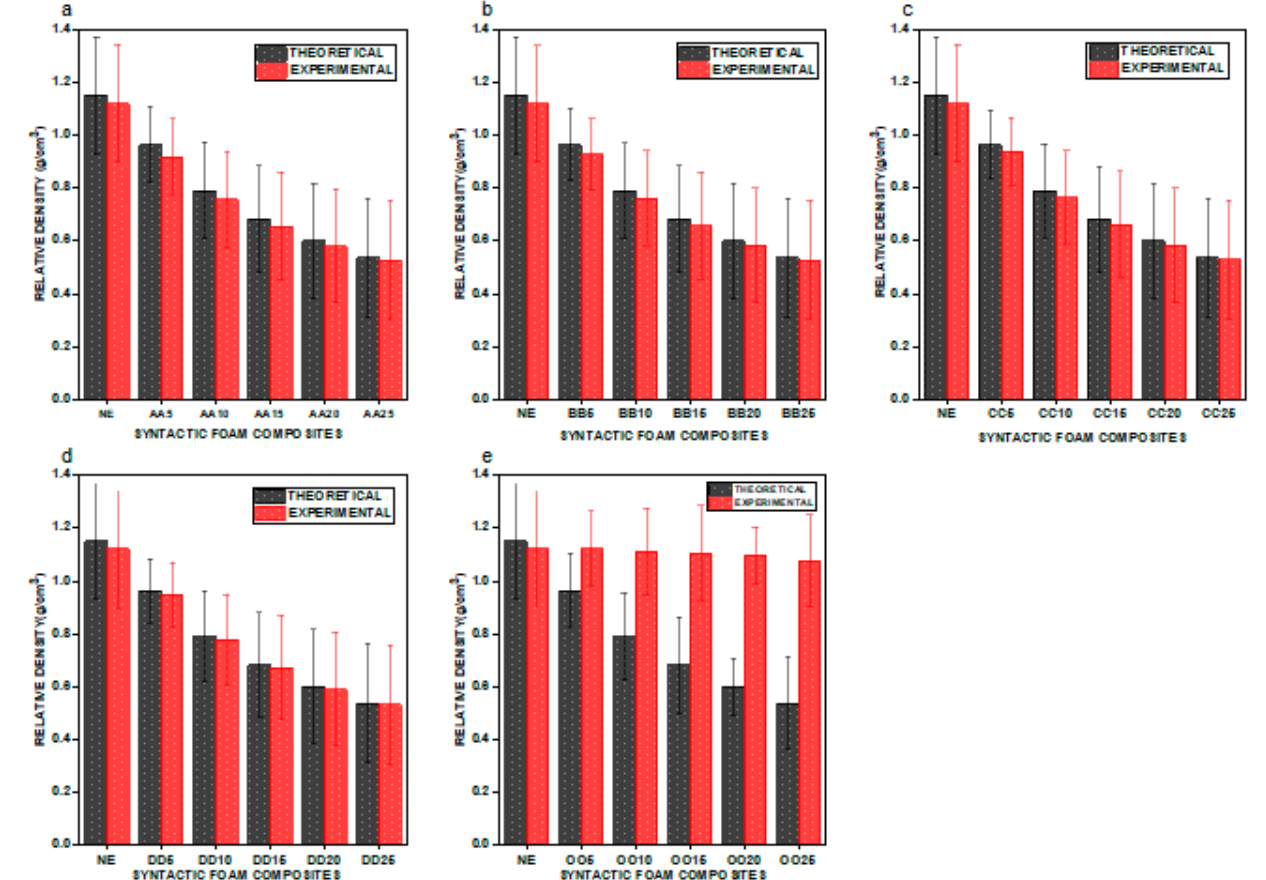
Figure 5. Graphical representation of experimental density versus theoretical density for ( a ) AA5, AA10, AA15, AA20, and AA25; ( b ) BB5, BB10, BB15, BB20, and BB25; ( c ) CC5, CC10, CC15, CC20, and CC25; ( d ) DD5, DD10, DD15, DD20, and DD25; ( e ) OO5, OO10, OO15, OO20, and OO25.